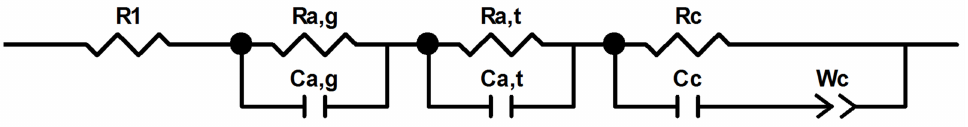
Figure 2. The equivalent circuit of